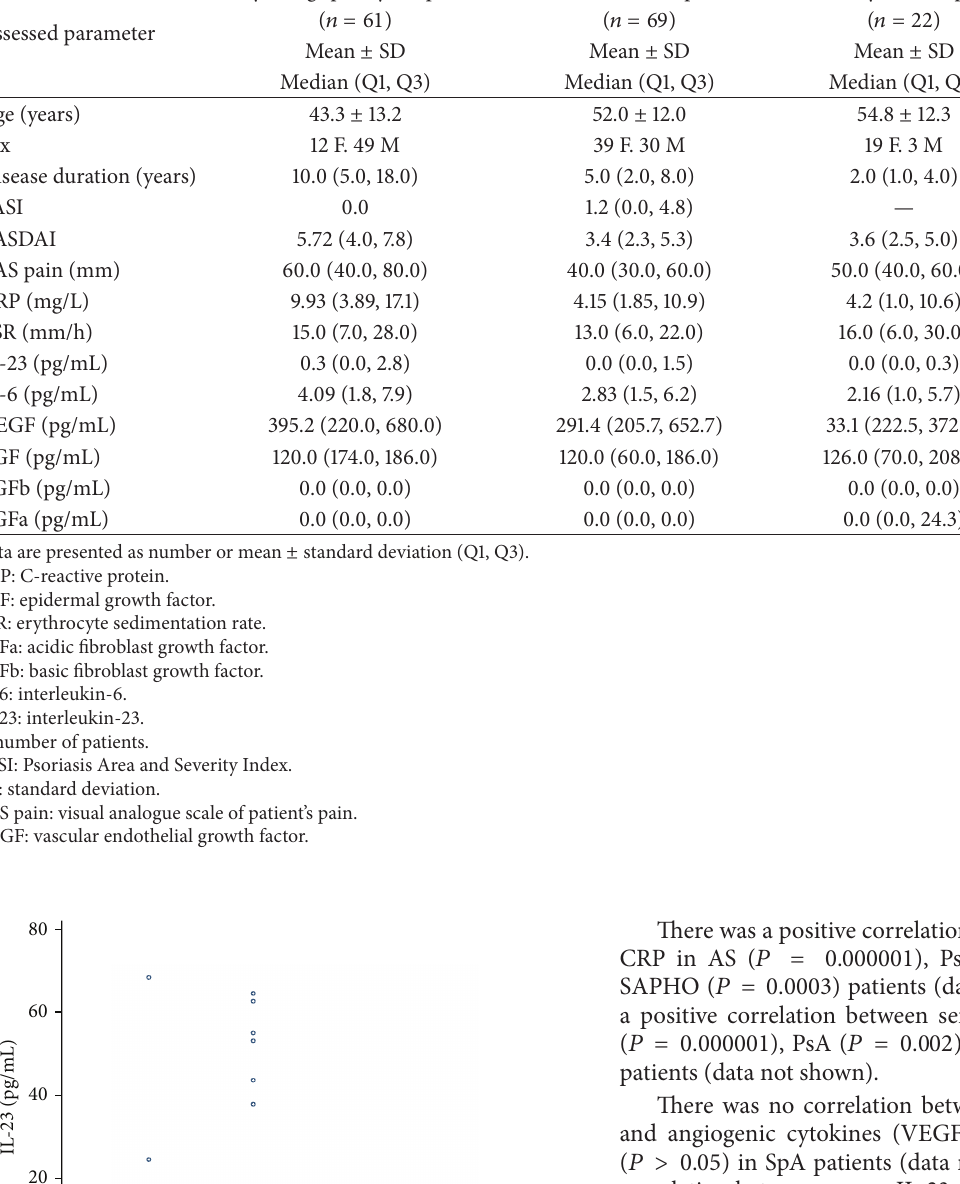
Table 1: Clinical and laboratory characteristics of ankylosing spondylitis, psoriatic arthritis, and SAPHO syndrome patients and healthy controls.